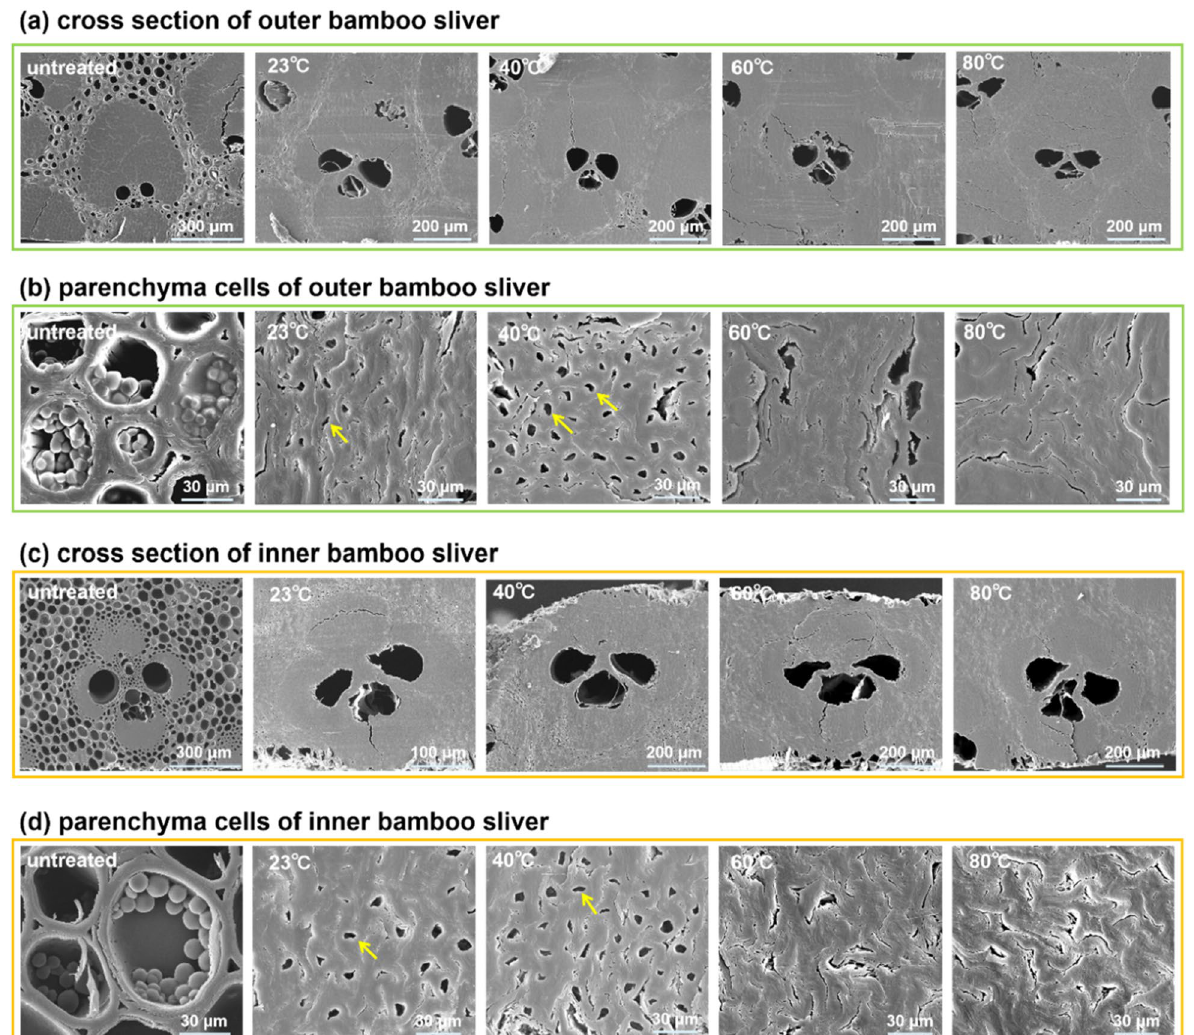
Fig. 2 SEM images of the microstructure of bamboo slivers treated with alkali at different temperatures. a Cross section of outer bamboo slivers; b cross section of inner bamboo slivers; c parenchyma cells in outer bamboo sliver; d parenchyma cells in inner bamboo